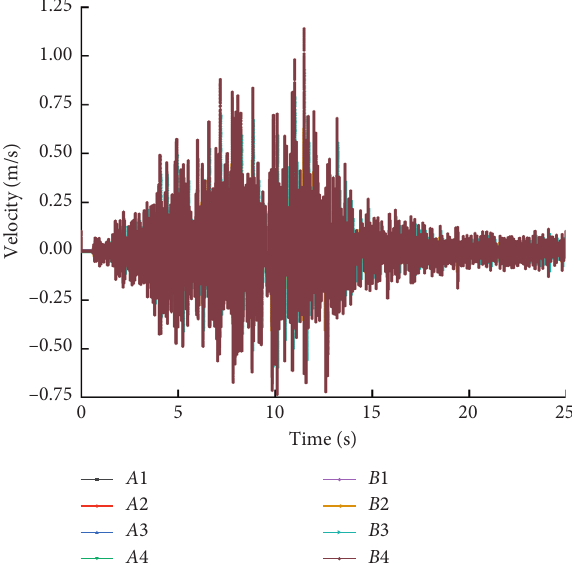
Figure 13: Speed time-history curve of each monitoring